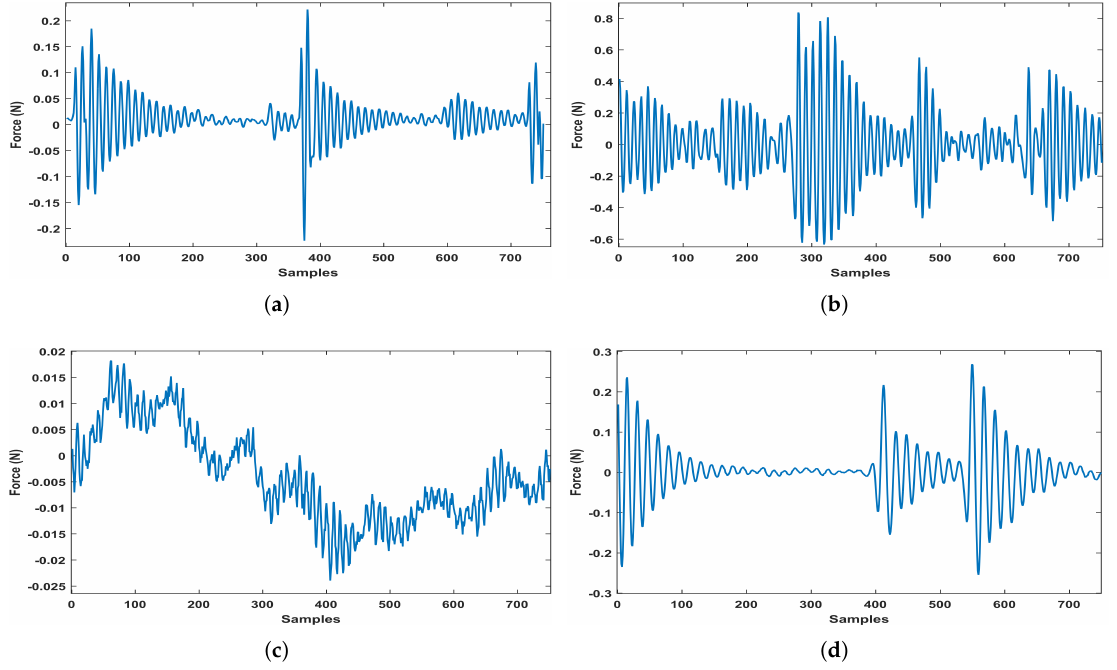
Figure 9. Bearing vibration signal taken from Ladisk: ( a ) signal with axial fault, ( b ) signal with contamination in lubricant fault, ( c ) new bearing vibration signal and ( d ) signal with radial